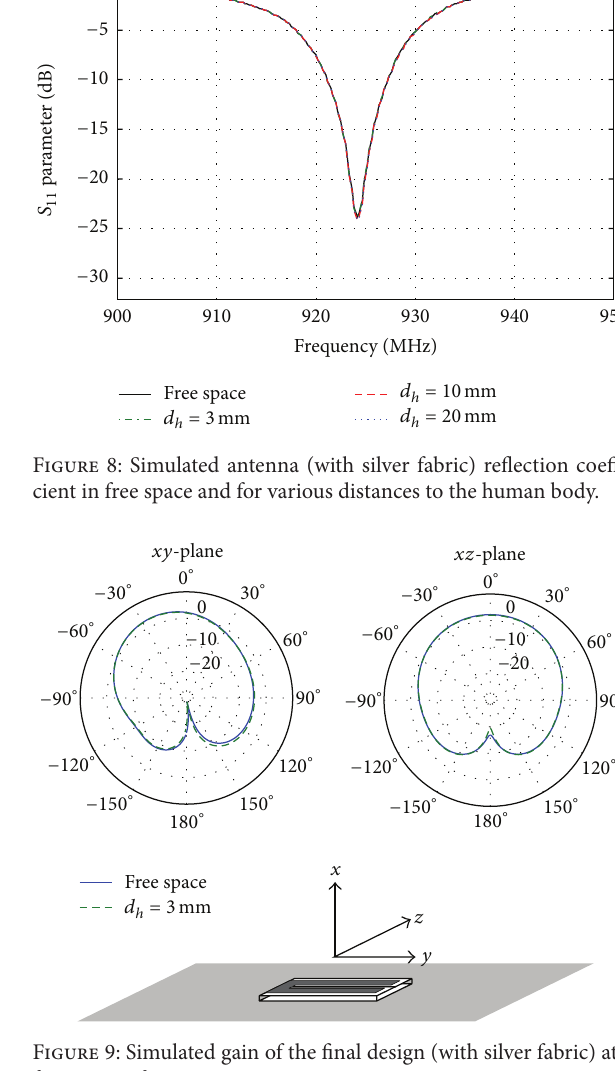
Figure 7: Simulated standalone antenna gain (without silver fabric) at a frequency of 923 MHz.